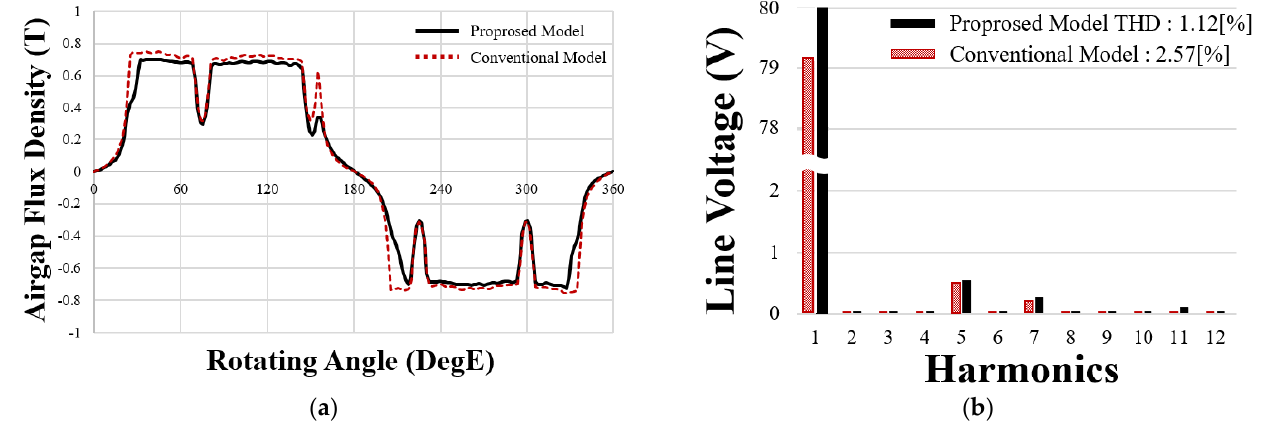
Figure 12. Comparison of the conventional and proposed models ( a ) air − gap magnetic flux density, ( b ) line voltage THD. ( b ) line voltage